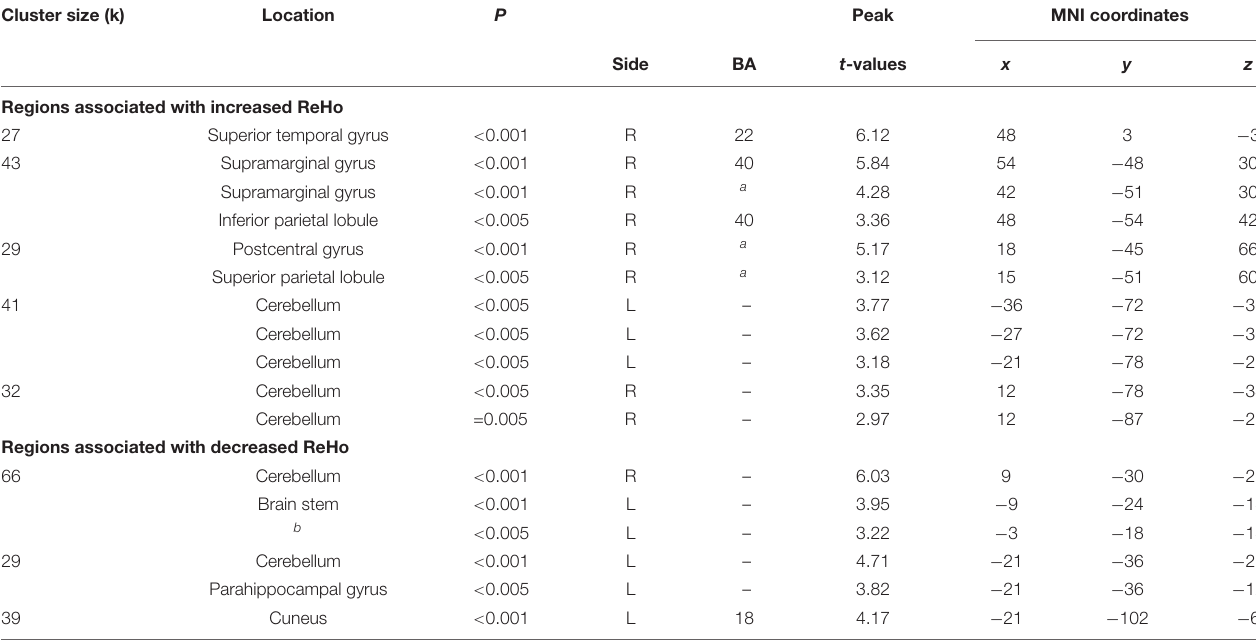
TABLE 6 | Localization of regions showing correlations between prospective disturbed dreaming frequency estimates and ReHo values in the NM group. Cluster size (k) Location P Peak MNI coordinates Side BA t -values y Regions associated with increased ReHo Superior temporal gyrus < 0.001